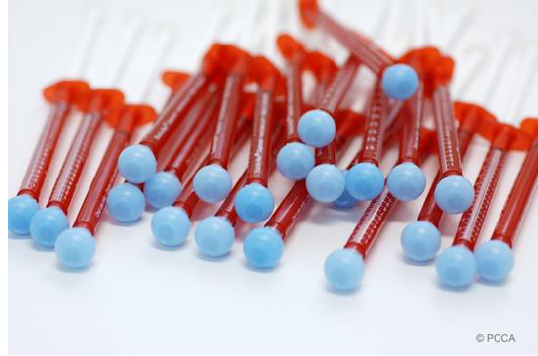
Figure 2. Single-dose syringes (courtesy of PCCA,